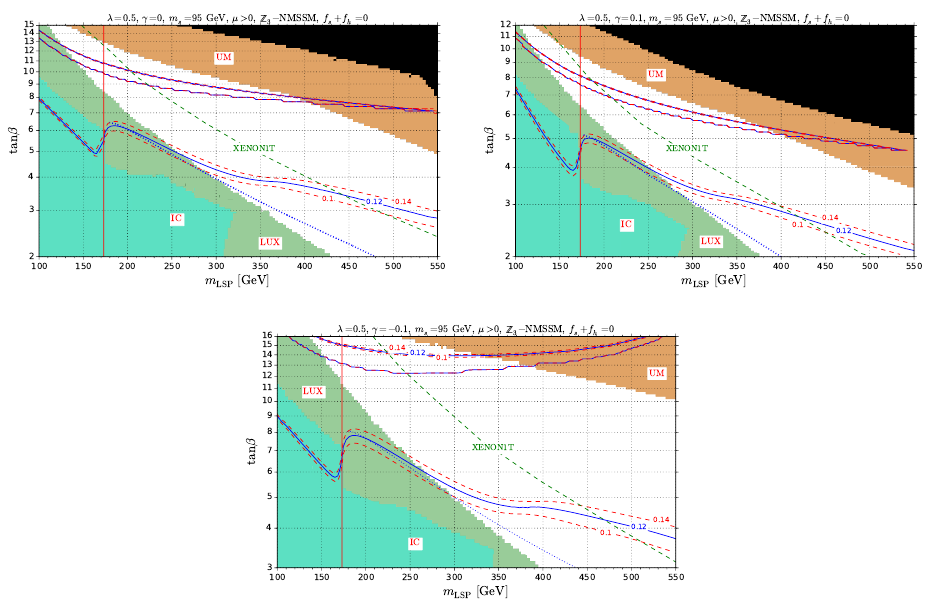
Figure 7 . The same as in (cid:12)gure 5 but in the Z 3 -invariant NMSSM and (cid:13) = (cid:0) 0 : 1 ; 0 ; 0 : 1. GeV. For small j (cid:13) j the a resonance occurs at the blind spot for tan (cid:12) of order 10. That is why tan (cid:12) typically decreases with m , as can be seen from (cid:12)gure 7. Local minimum for LSP tan (cid:12) is present only in the lower panel of (cid:12)gure 7 because more negative values of (cid:13) lead